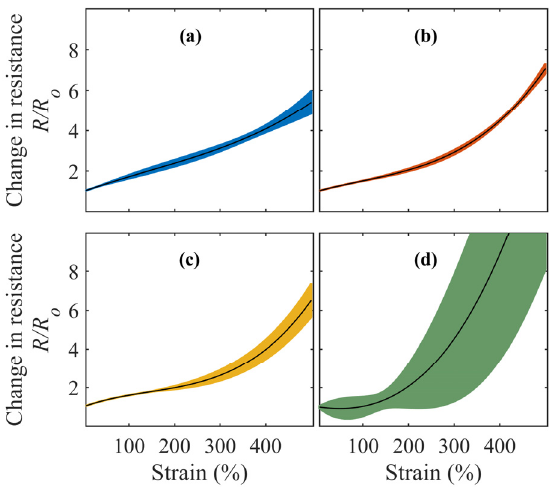
Figure 5. Change in resistance observed across twelve samples of CB:Ecoflex grouped by different weight ratio percentages of 1:8 ( a ), 1:9 ( b ), 1:10 ( c ), and 1:11 ( d ). Resistance changes were reported while the samples were subjected to three stretching cycles.